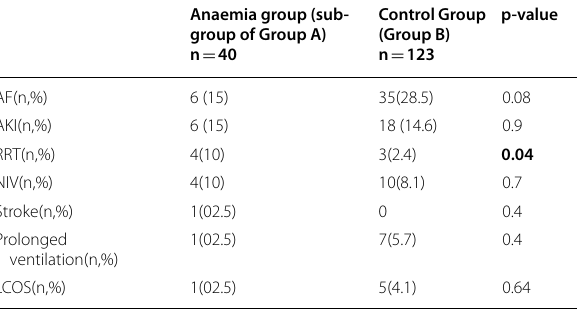
Table 2 Comparison of the sub group of Group A (ID) patients with anae- mia to Group B (control) shows a statistically significant different in the use of Renal Replacement Therapy in anaemic iron deficient